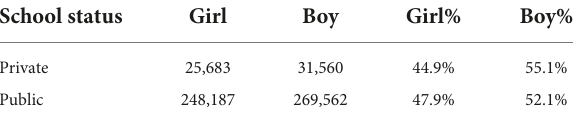
TABLE 7 Distribution of pupils in private and public